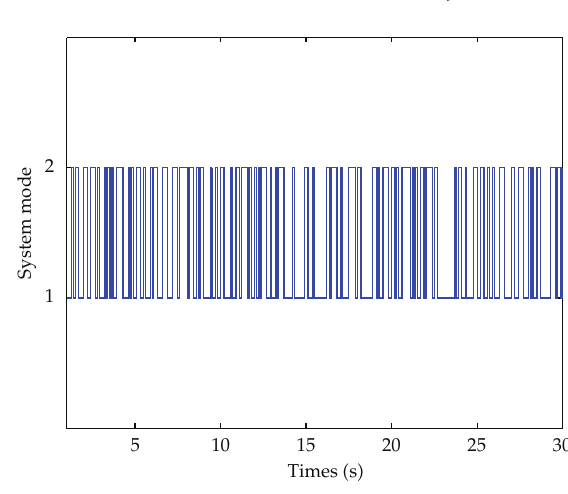
Figure 1: System jumping